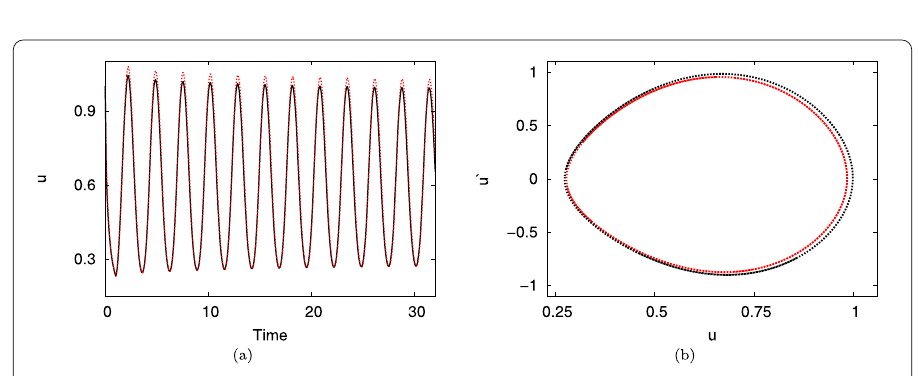
Figure 9 (color online) Shows phase-plane maps for the population density u . The semi-analytical two-term solution shown by black dotted line and the numerical solution represented by red solid line with τ = 5 and μ = 2 are